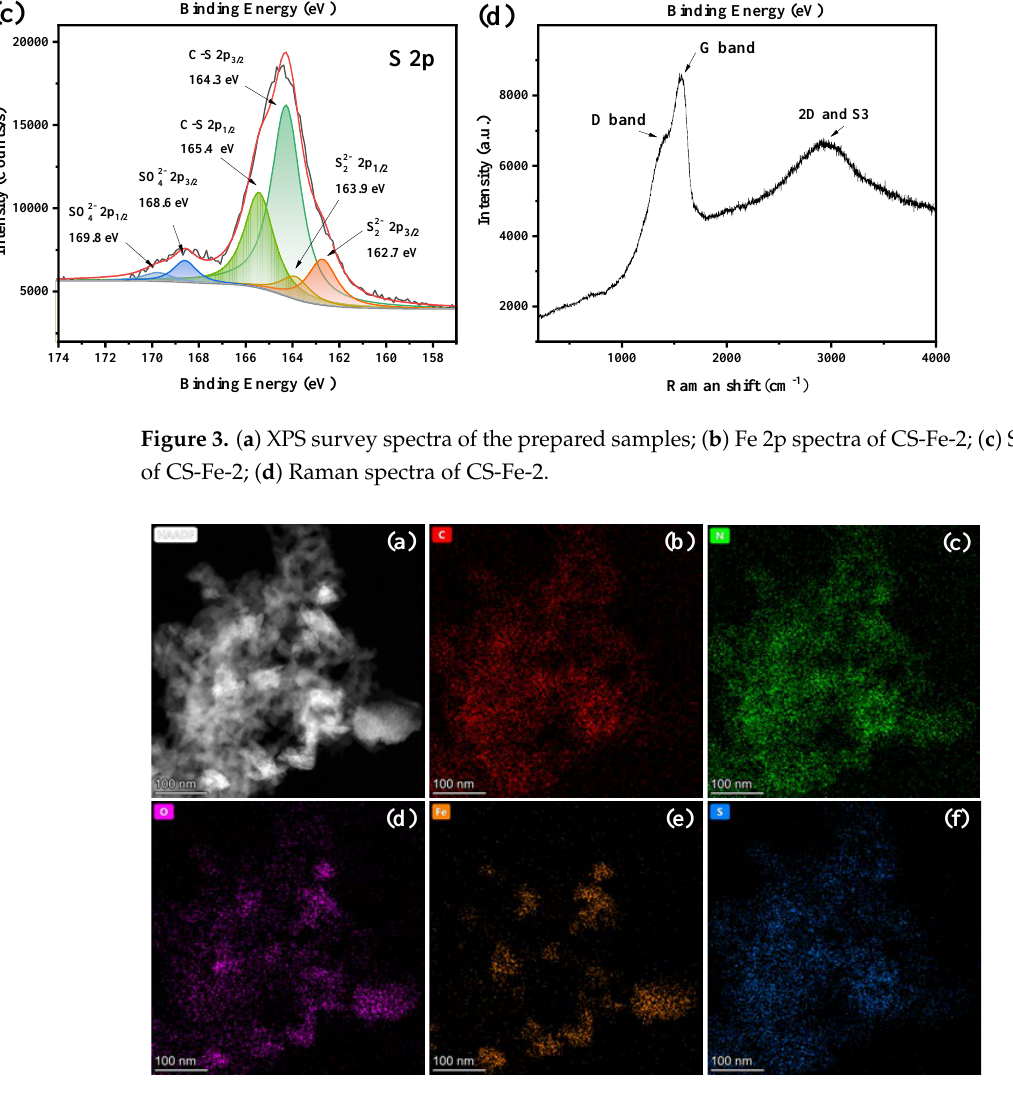
Figure 4. ( a ) HADDF images and ( b – f ) elemental mapping of